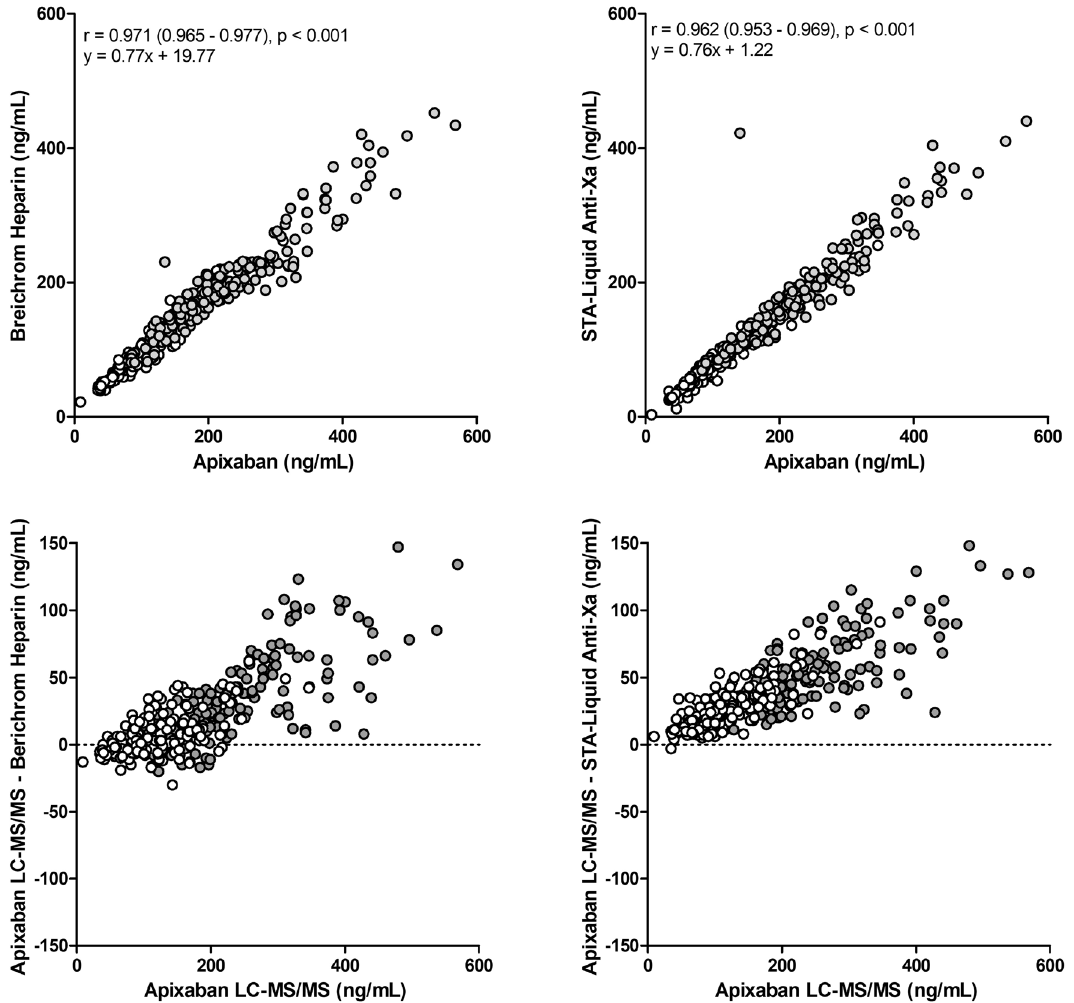
Figure 1. Correlations between apixaban plasma concentrations measured by liquid chromatography-tandem mass spectrometry (LC–MS/MS) and two anti-Xa assays, measured in two different laboratories (upper panel) and Bland–Altman plot (lower panel). Full circles at peak and empty circles at